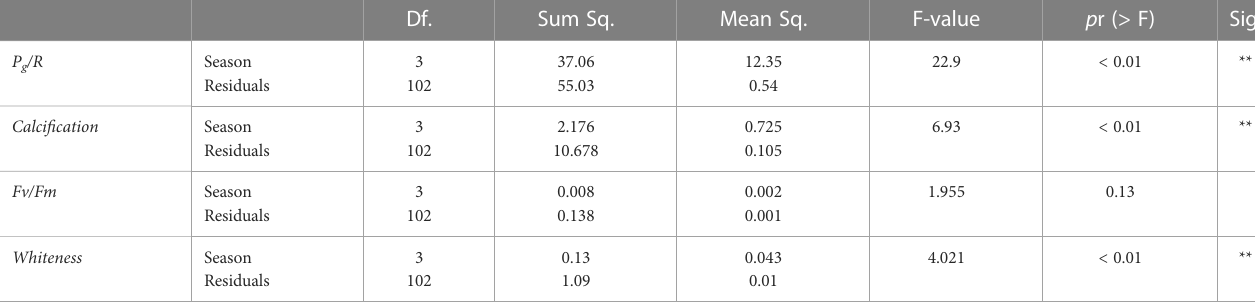
Df, degrees of freedom; Sum Sq., sum of squares; Mean Sq., mean sum of squares; F-value, F statistics; pr (> F), p-value of the F statistics; Sig., signi fi cance p-value, where ** indicates p< 0.01.